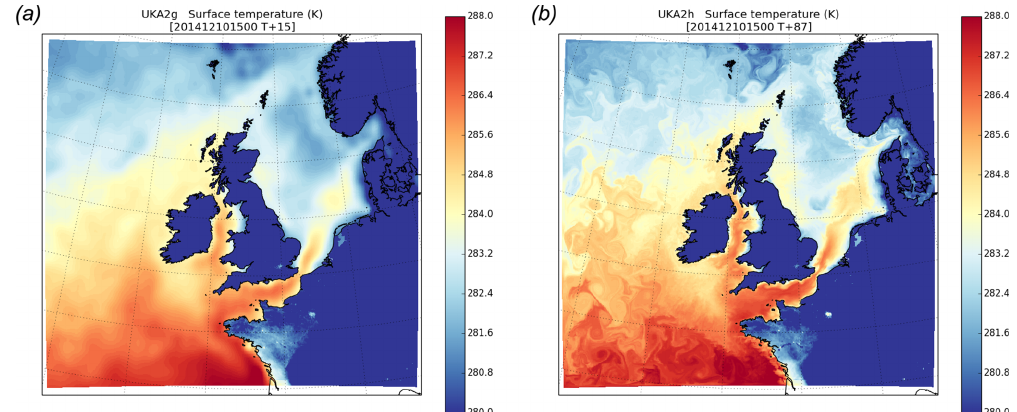
Figure 3. Sample snapshot case study output of surface temperature showing (a) UKA2g: persisted SST interpolated from a 17km resolu- tion global Met Office Unified Model run and (b) UKA2h: persisted SST interpolated from 1.5km resolution UKO2 ocean run. Note the temperature scale is truncated to highlight SST variability rather than the (evolving) land temperatures.